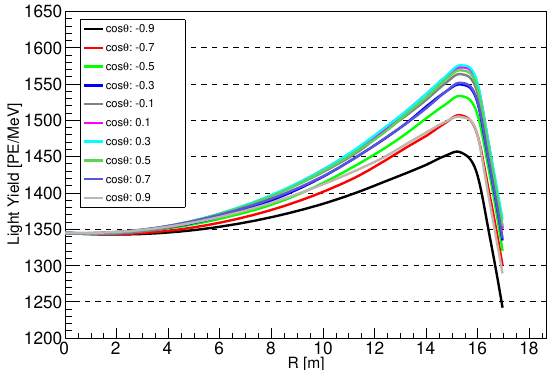
Figure 8 . Mean number of PEs per MeV for 2.22 MeV gammas as a function of the radius, along a few representative polar